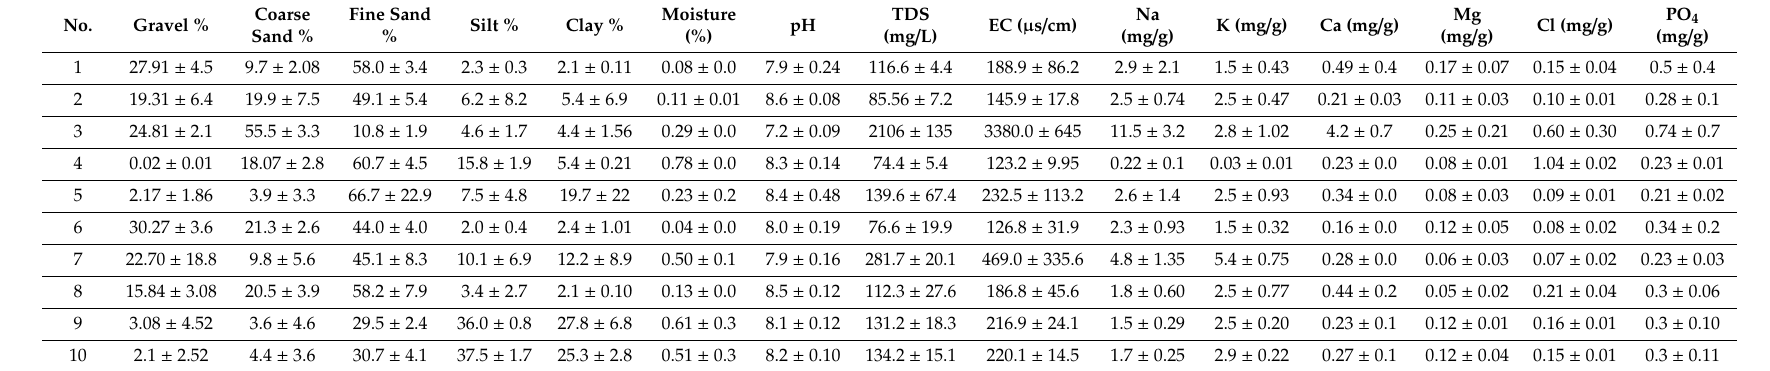
Table 3. Soil variables ± SD values in the collected soil samples of the 10 examined populations of A.javanica